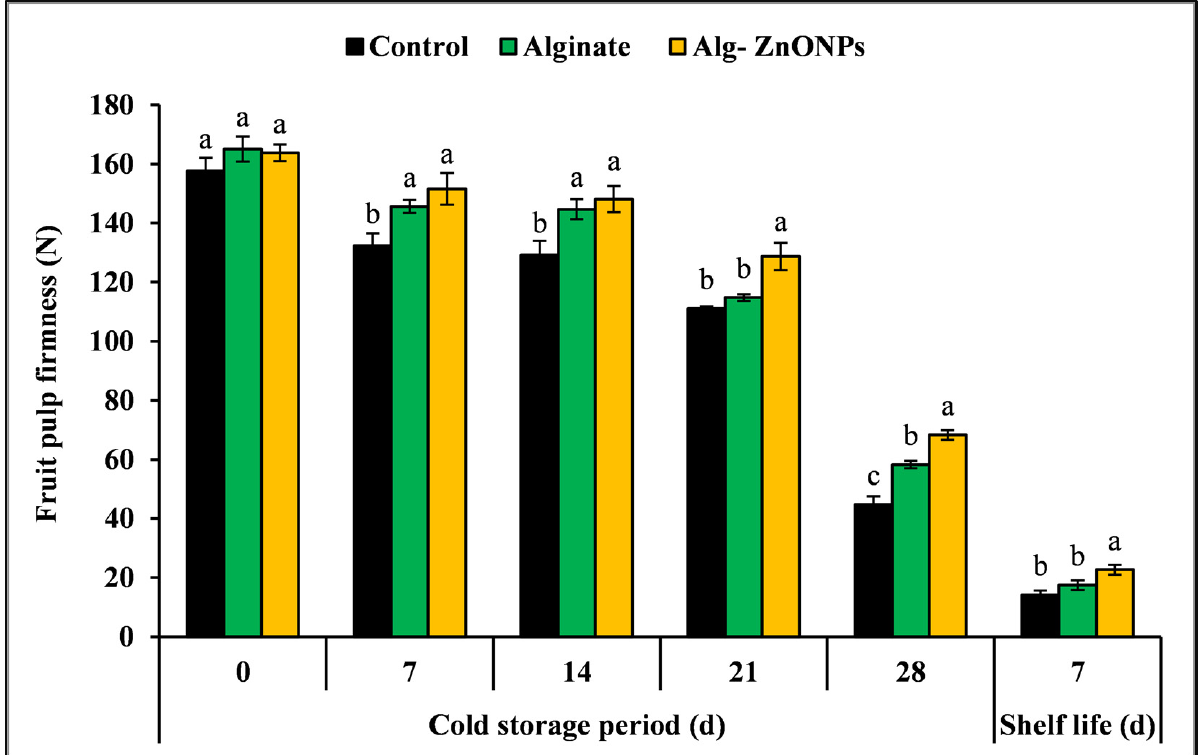
Figure 9. Effect of Alg–ZnO NPs on pulp firmness of “Kiett” mango fruits during cold storage and shelf life; vertical bars represent the standard error (SE). Bars marked with the same letter in each sampling date are not significantly different with 95% confidence according to Duncan’s multiple range test.